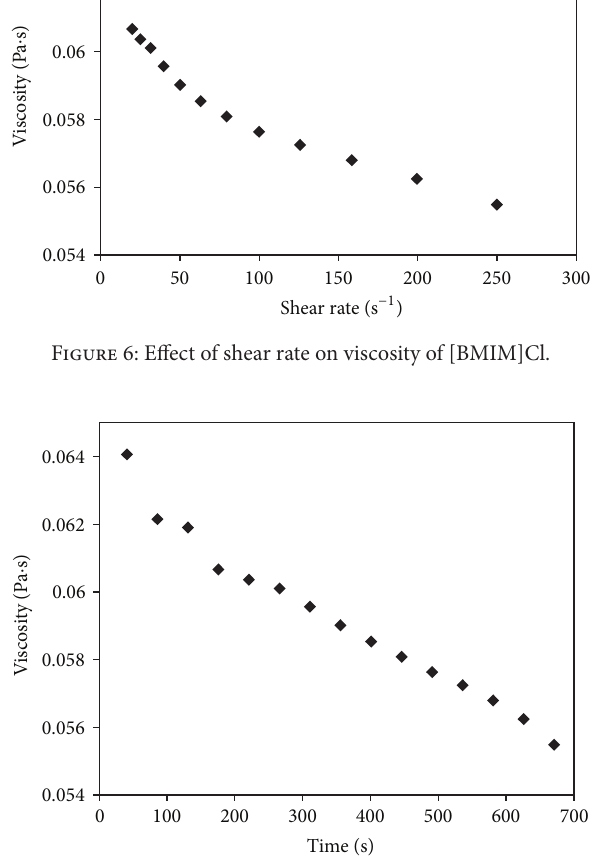
Figure 7: Effect of reaction time on viscosity of [BMIM]Cl at constant temperature (298.2